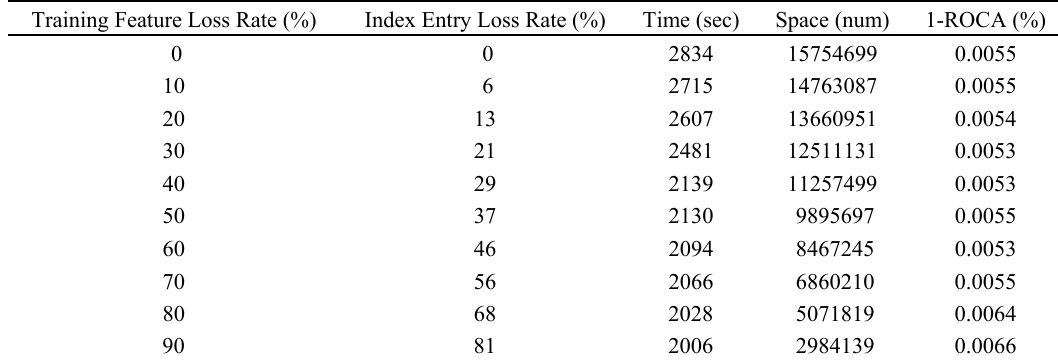
Table 5. Training Feature Loss Rate, Index Entry Loss Rate and